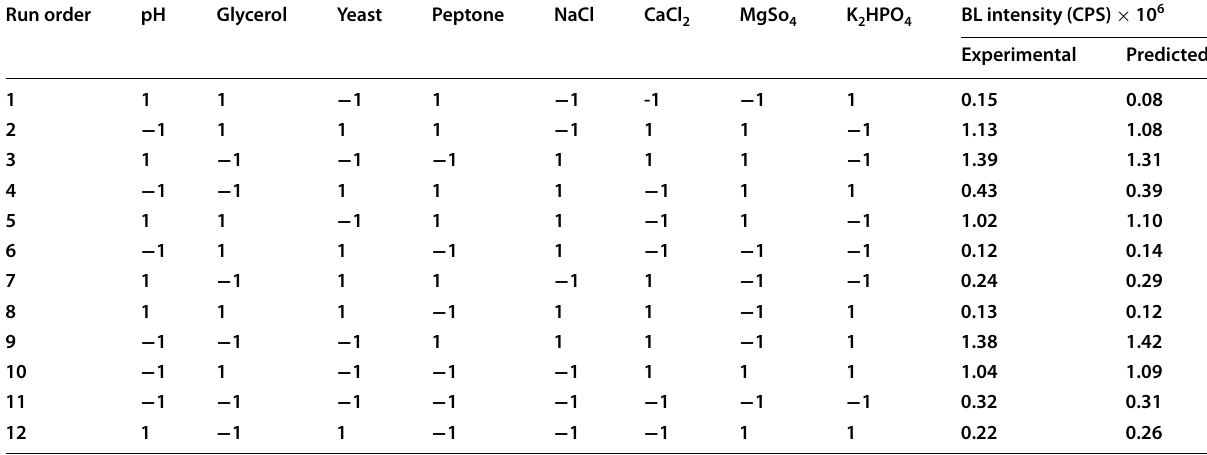
Table 4 PBD matrix to evaluate the significant variables affecting BL intensity Run order pH Glycerol Yeast Peptone